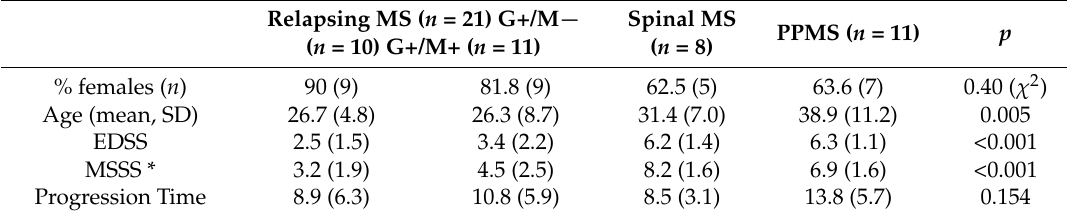
Table 4. Characteristics of MS patients according to new proposal and working classification. SD: standard deviation; NA: not applicable; EDSS: expanded disability status scale; MSSS: multiple sclerosis severity score.